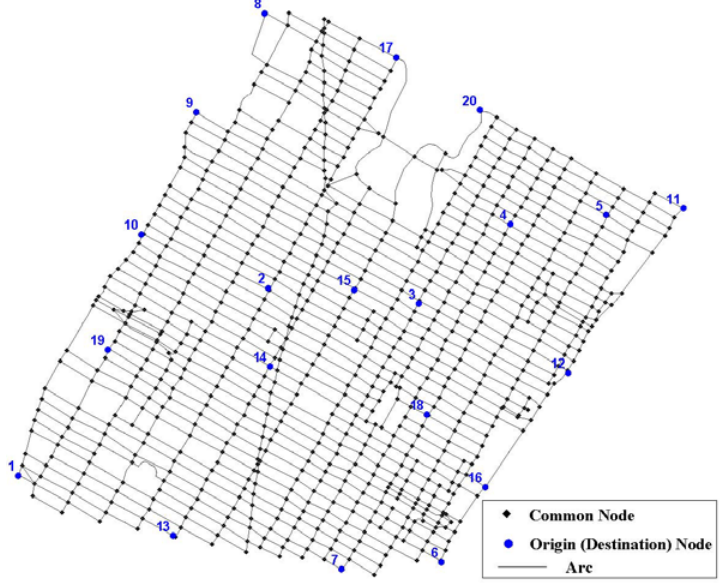
Fig. 2 The real road network for comparative computational time analysis Table 2. Computational times of HIAs in a real transportation